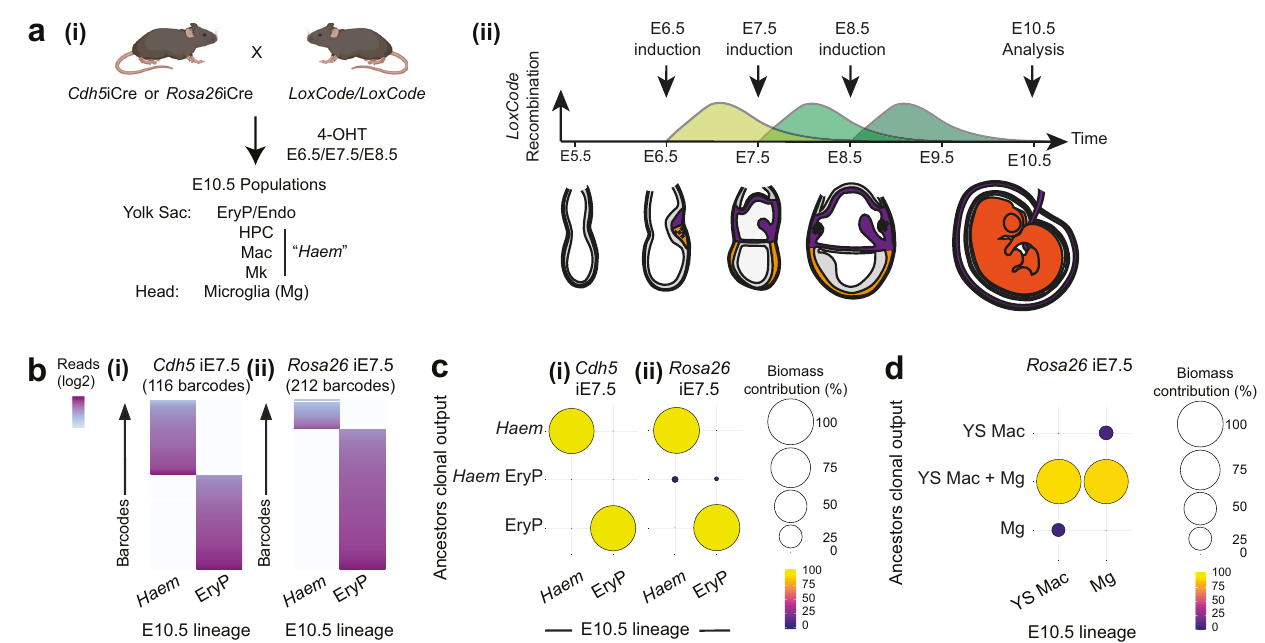
Fig. 3 | Benchmarking LoxCode barcoding in the yolk sac. a (i) Experimental design for barcoding experiments. Experimental mice received only one dose of 4-OHT (at either E6.5, E7.5, or E8.5). Created with BioRender.com. (ii) Barcoding window in reference to 4-OHT injection time. b Primitive erythrocytes/ Haem rela- tionships after Cdh5 iCre induction at E7.5 ((i), 116 informative barcodes, n =5 embryos) and Rosa26 iCre induction at E7.5 ((ii), 212 informative barcodes, n =3